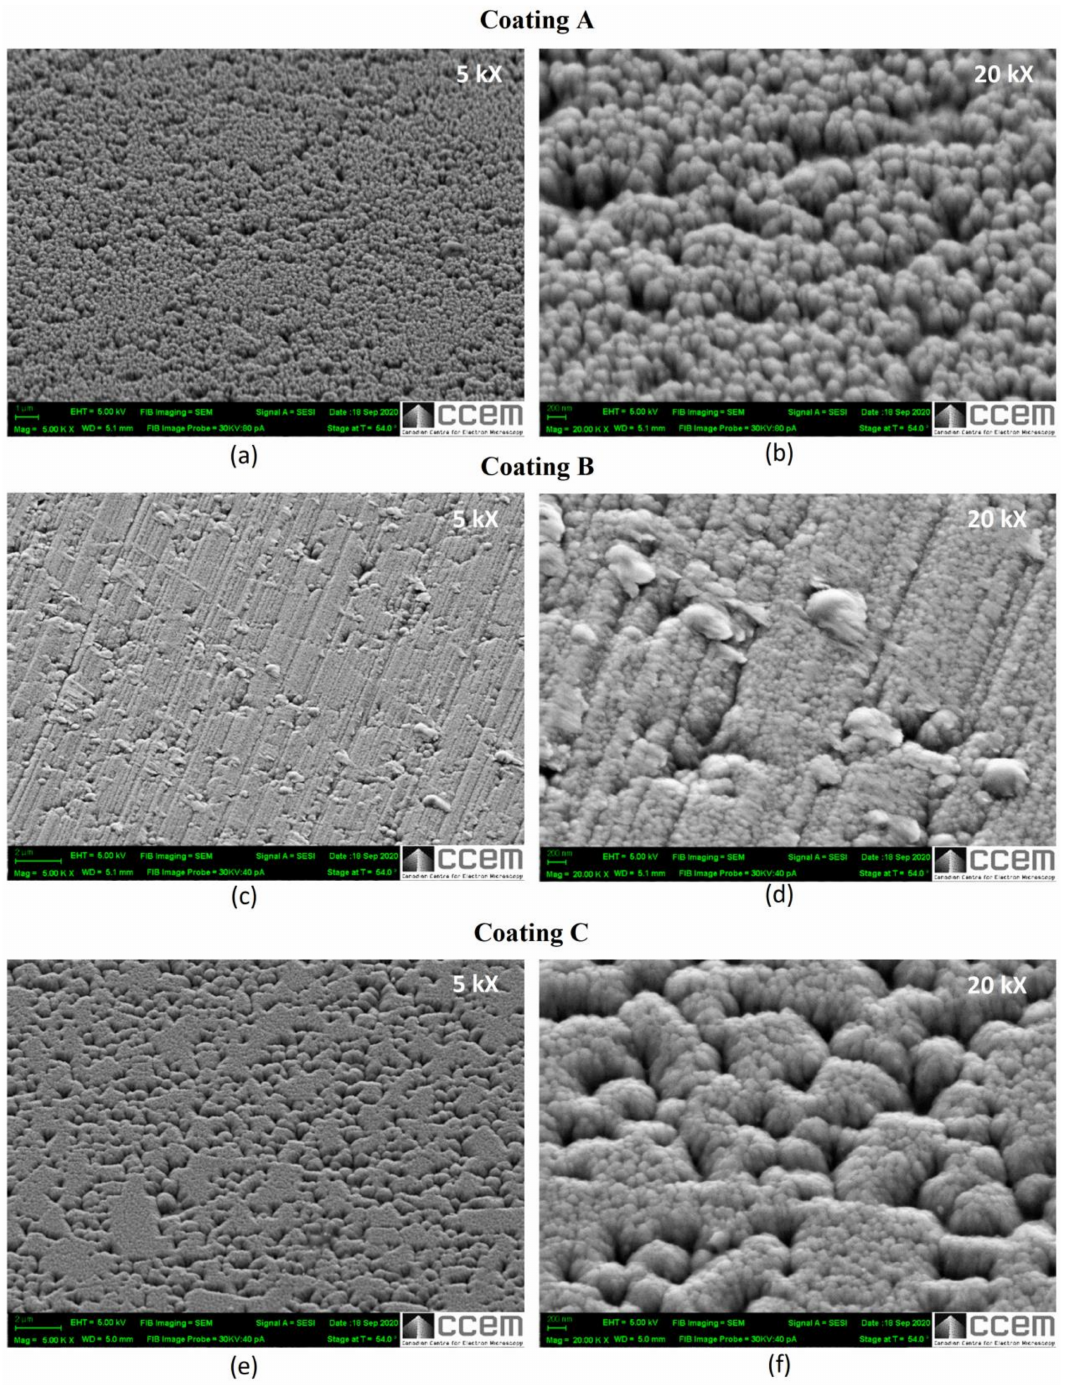
Figure 7. SEM surface morphology of the three TiB 2 coatings: ( a , c , e ) at low magnification, ( b , d , f ) at high